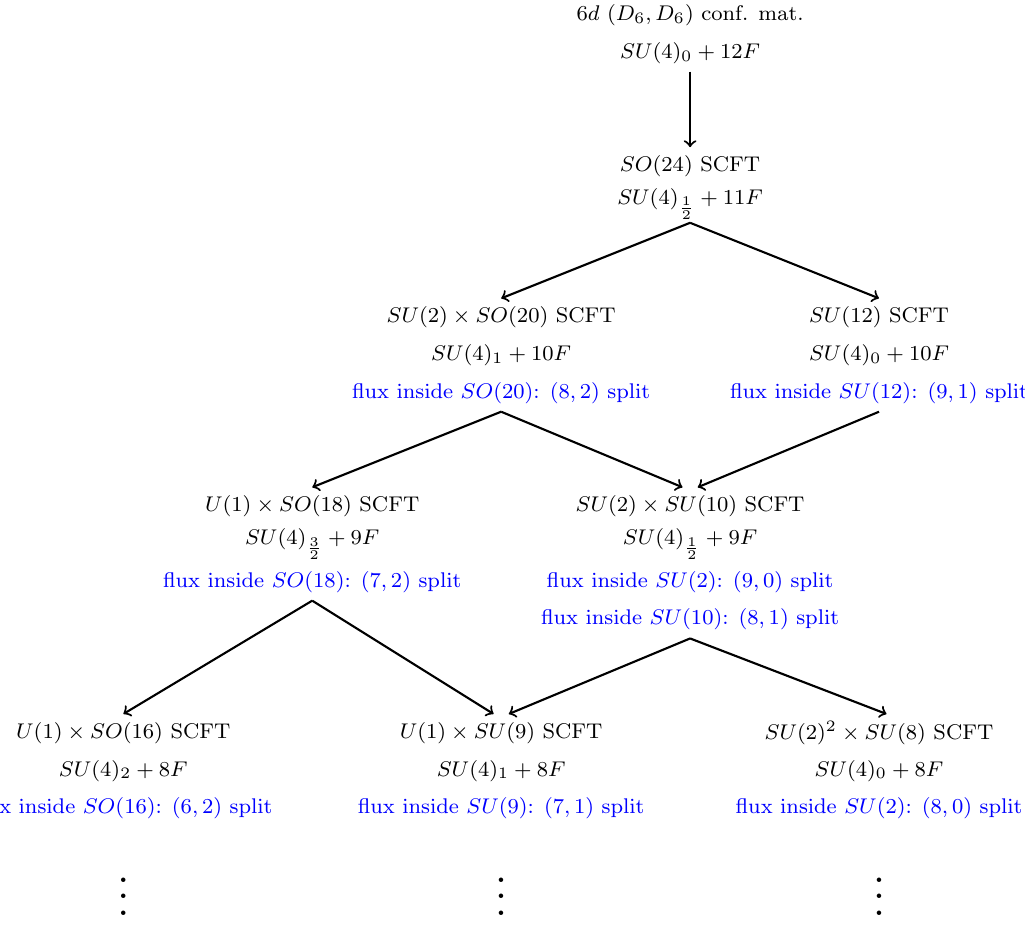
Figure 11 . Flow pattern triggered by mass deformations for the rank N = 3 case. At each step we specify the 5 d SCFT ( 6 d SCFT for the first step), the 5 d gauge theory based on SU group that is UV completed by it and the split of the associated 3 d N = 2 theory that is obtained from the torus compactifications. For some SCFTs we can have more splits and each one is associated with a different factor inside the 5 d global symmetry for which we turn on the